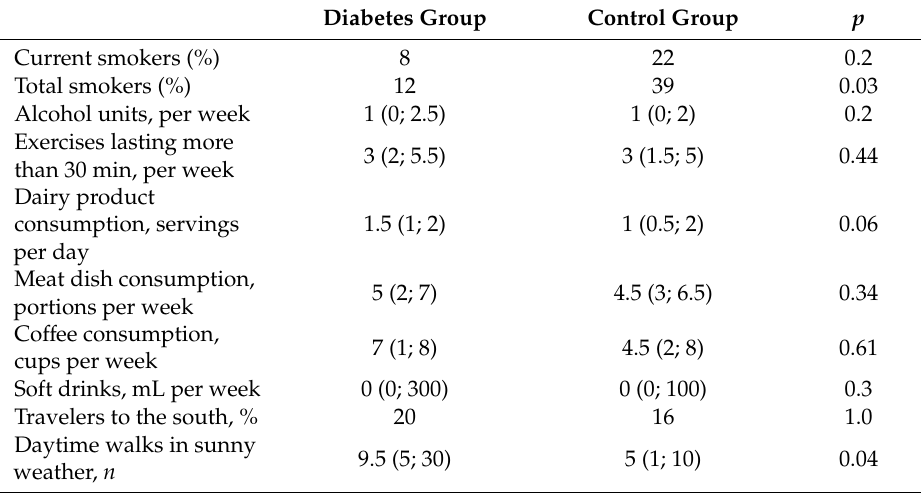
Table 3. Questionnaire